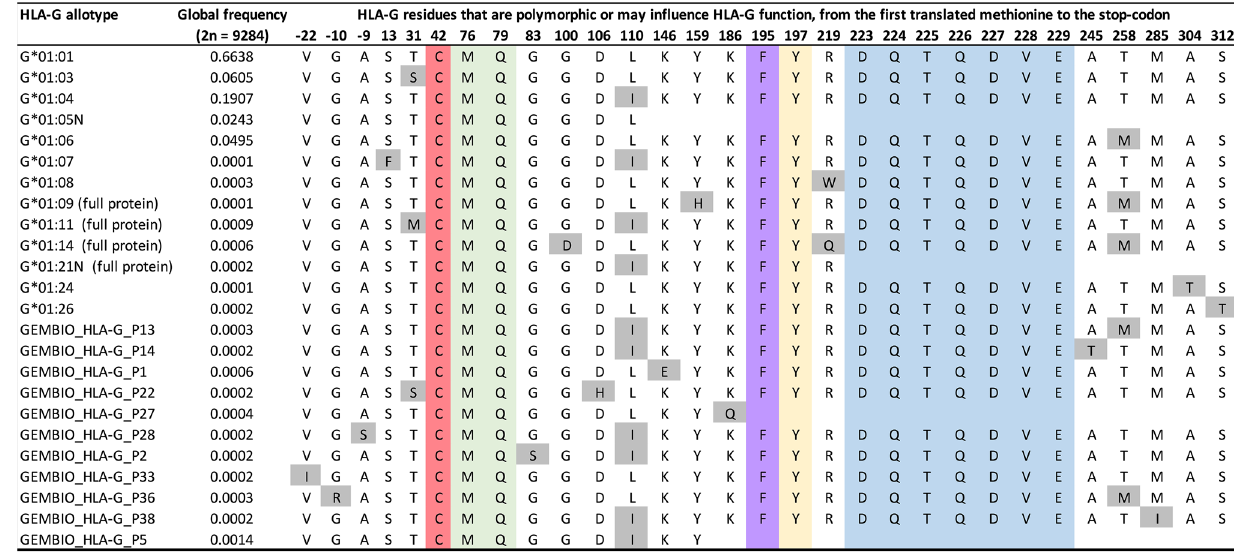
Figure 6. HLA-G residues that are polymorphic or may influence HLA-G function, considering known allotypes detected in 4642 samples from across the world and new allotypes that have occurred at least twice. Polymorphic residues are marked in shades of gray. Important residues for the HLA-G function are marked in other colors. For allotypes with premature stop-codons, there is no amino acid indication after the frameshift mutation. In red, the Cysteine responsible for dimer formation. In green, the Methionine and Glutamine that interact with KIR2DL4. In purple and yellow, the important residues for ILT-2 and ILT-4 interaction. In blue, the motif DQTQDVE, which interacts with the TCD8